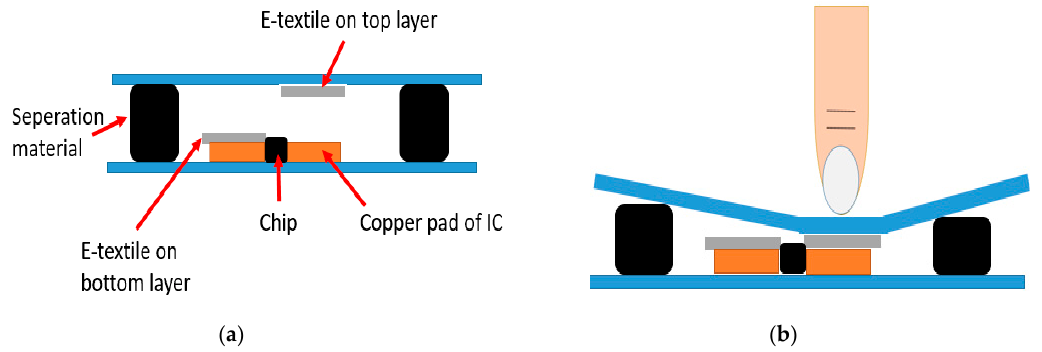
Figure 3. Status of the platform. ( a ) Before touching; ( b ) during touching.